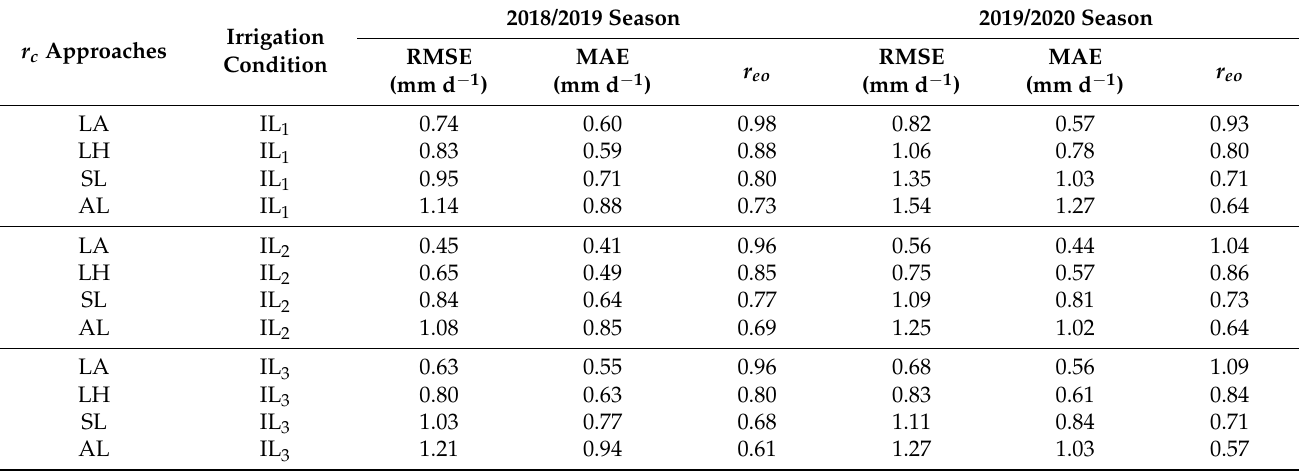
Table 3. Statistical evaluation of daily average ET cp estimated by canopy resistance approach for the different irrigation level conditions on potato crop